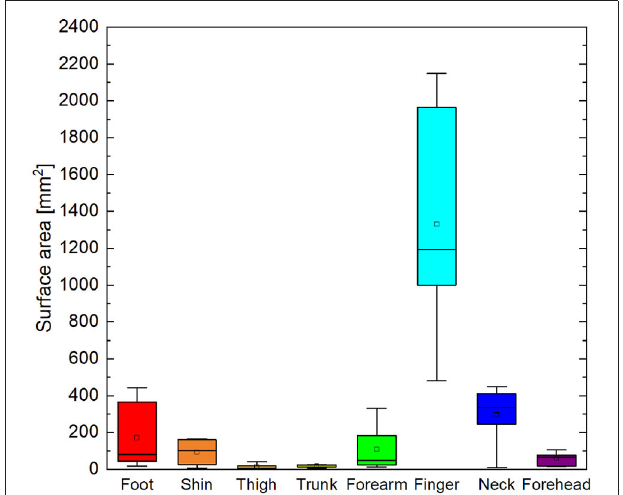
FIGURE 5 | Box and whisker plot of total area of surface elements within ROI correlated to cutaneous stimuli with ρ ≥ 0.45. Boxes delineate 95% confidence interval for each cutaneous area. Median is shown as horizontal line in each box. Whiskers show minima and maxima.